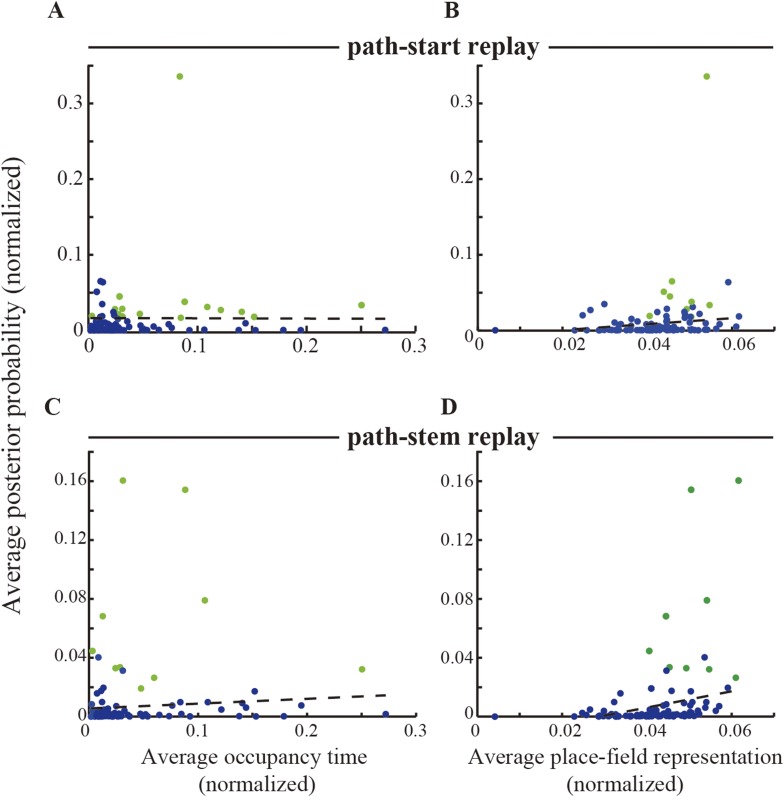
The relationship between occupancy time / place-field distribution and path replay representation.(A, B) Average normalized posterior probability of decoded locations as a function of (A) average normalized occupancy time which the rat spent, and (B) average normalized place-field representation (i.e., firing rate), at the locations decoded by the Bayesian decoder for the path-start replays that occurred in the start zone. To examine whether the initiation bias could be correlated with either occupancy time or spatial distribution of place-field representation, replays were divided into two types: those for which the average normalized posterior probability of decoded locations was greater than the overall mean + SD (i.e., replays showing relatively higher probability; green dots) and the rest (blue dots). Black dashed lines indicate the best-fit lines (linear least squares) for the blue dots. Pearson's r: (A) −0.012 (p = 0.91), (B) 0.27 (p = 0.010). (C, D), as for (A, B), but for the path-stem replays that occurred within the maze stem. Pearson's r: (C) 0.087 (p = 0.41), (D) 0.27 (p = 0.0098). Replays showing relatively higher probability (green dots) did not lie along the best-fit lines. Thus, neither occupancy time nor place-field representation could account for the posterior probability of decoded locations for either the path-start or the path-stem replays.